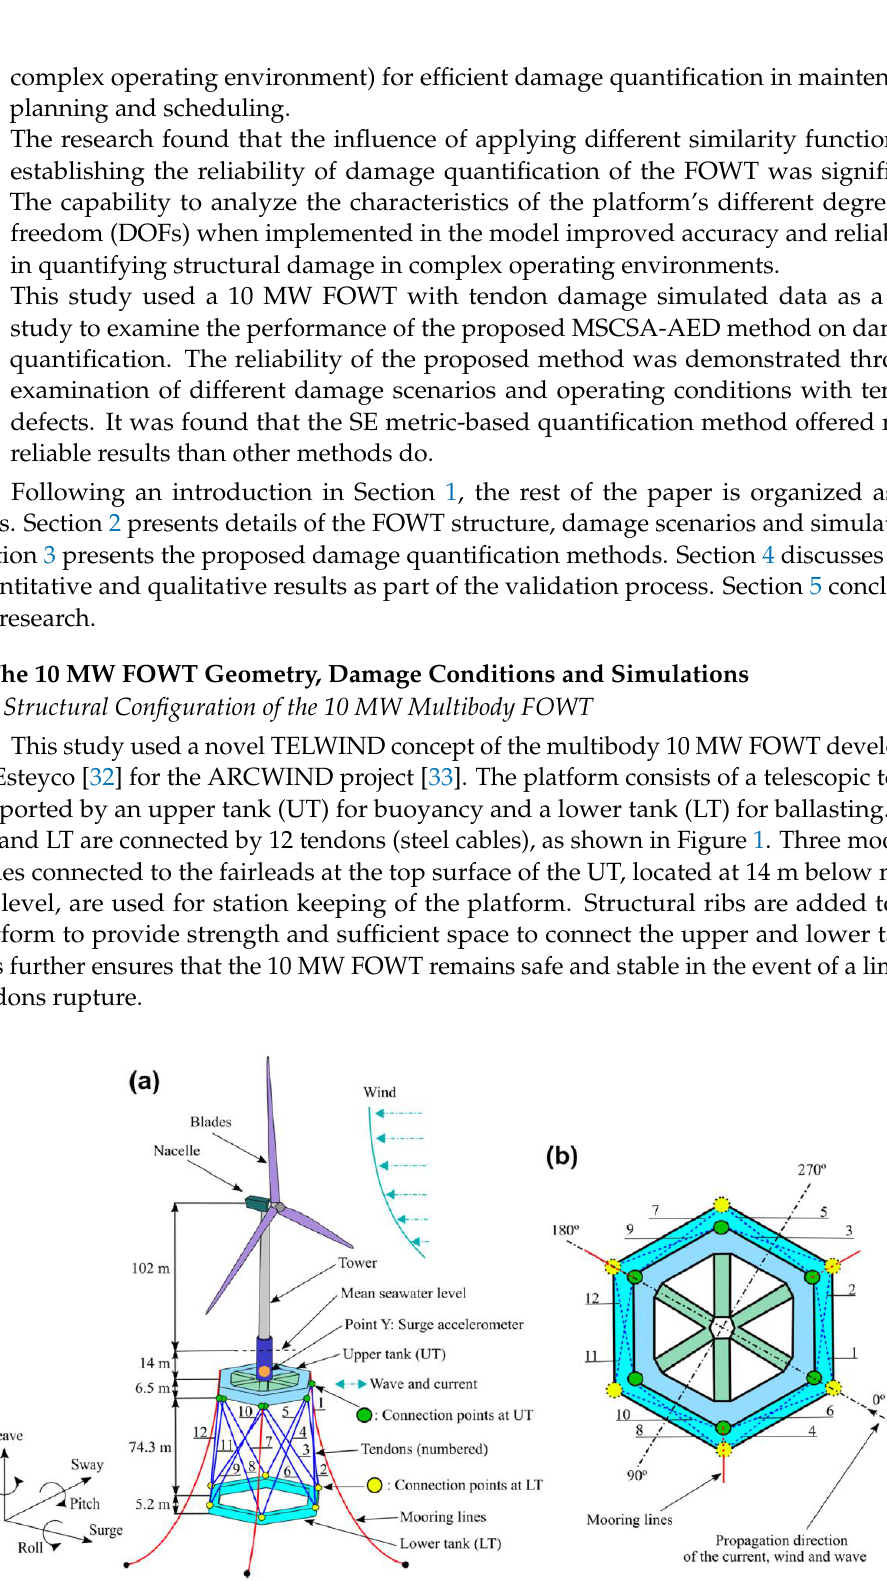
Table 1. The varying EOC details. Wind Speed (m/s)